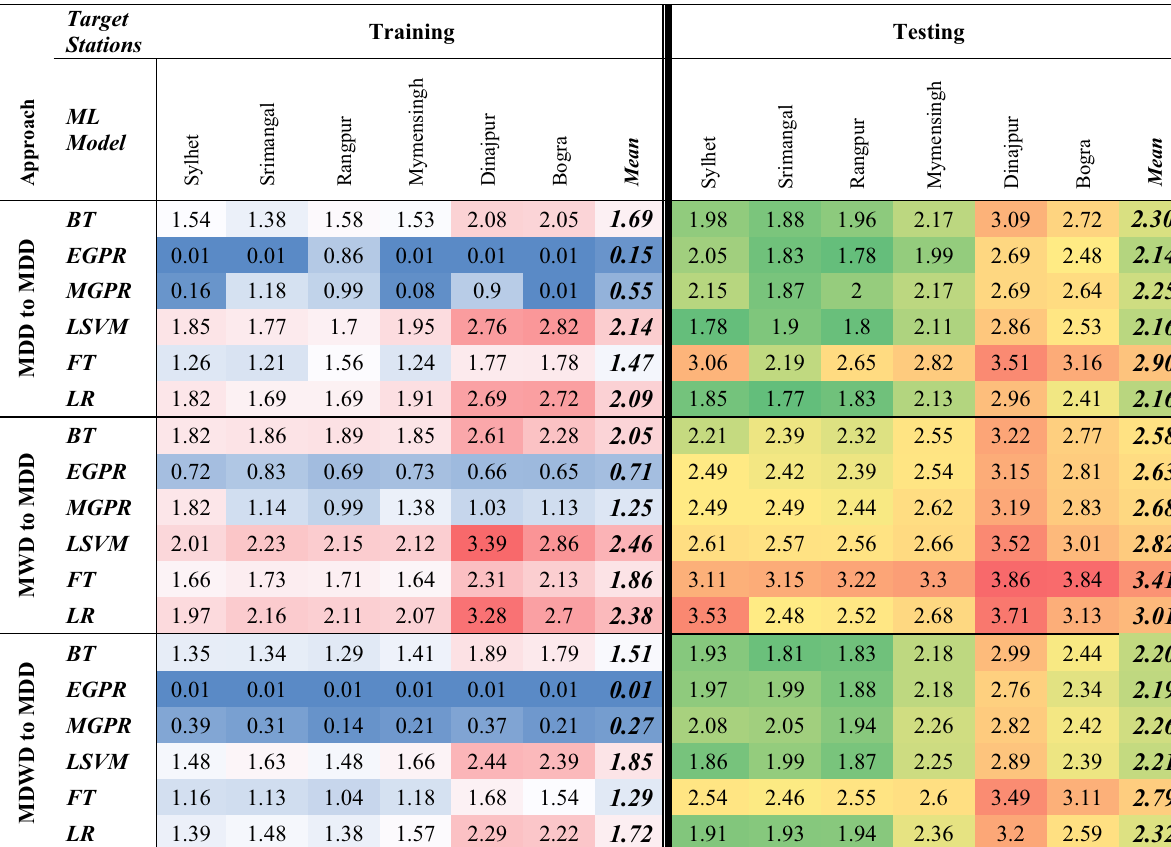
Table 2. RMSE of the ML models for the approaches (1) MDD to MDD (2) MWD to MDD & (3) MDWD to MDD. Significant values are in bold and